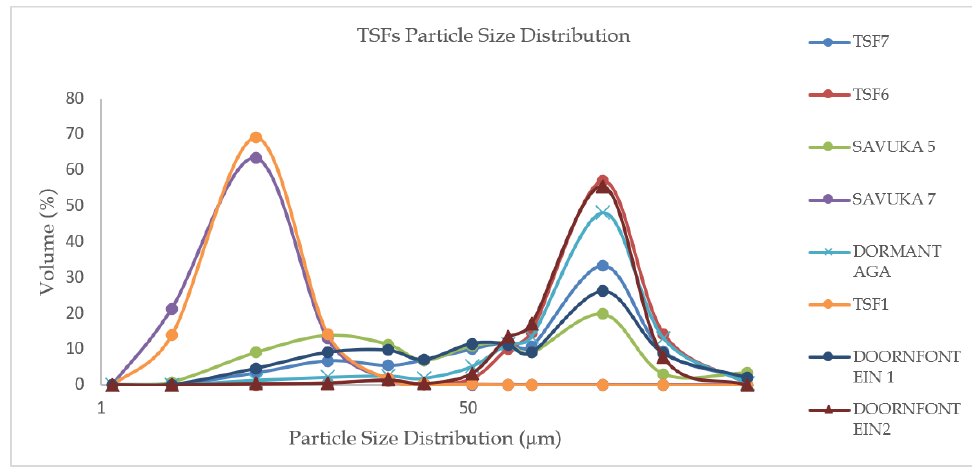
Figure 4. Particle size distribution for study site tailings storage facilities.